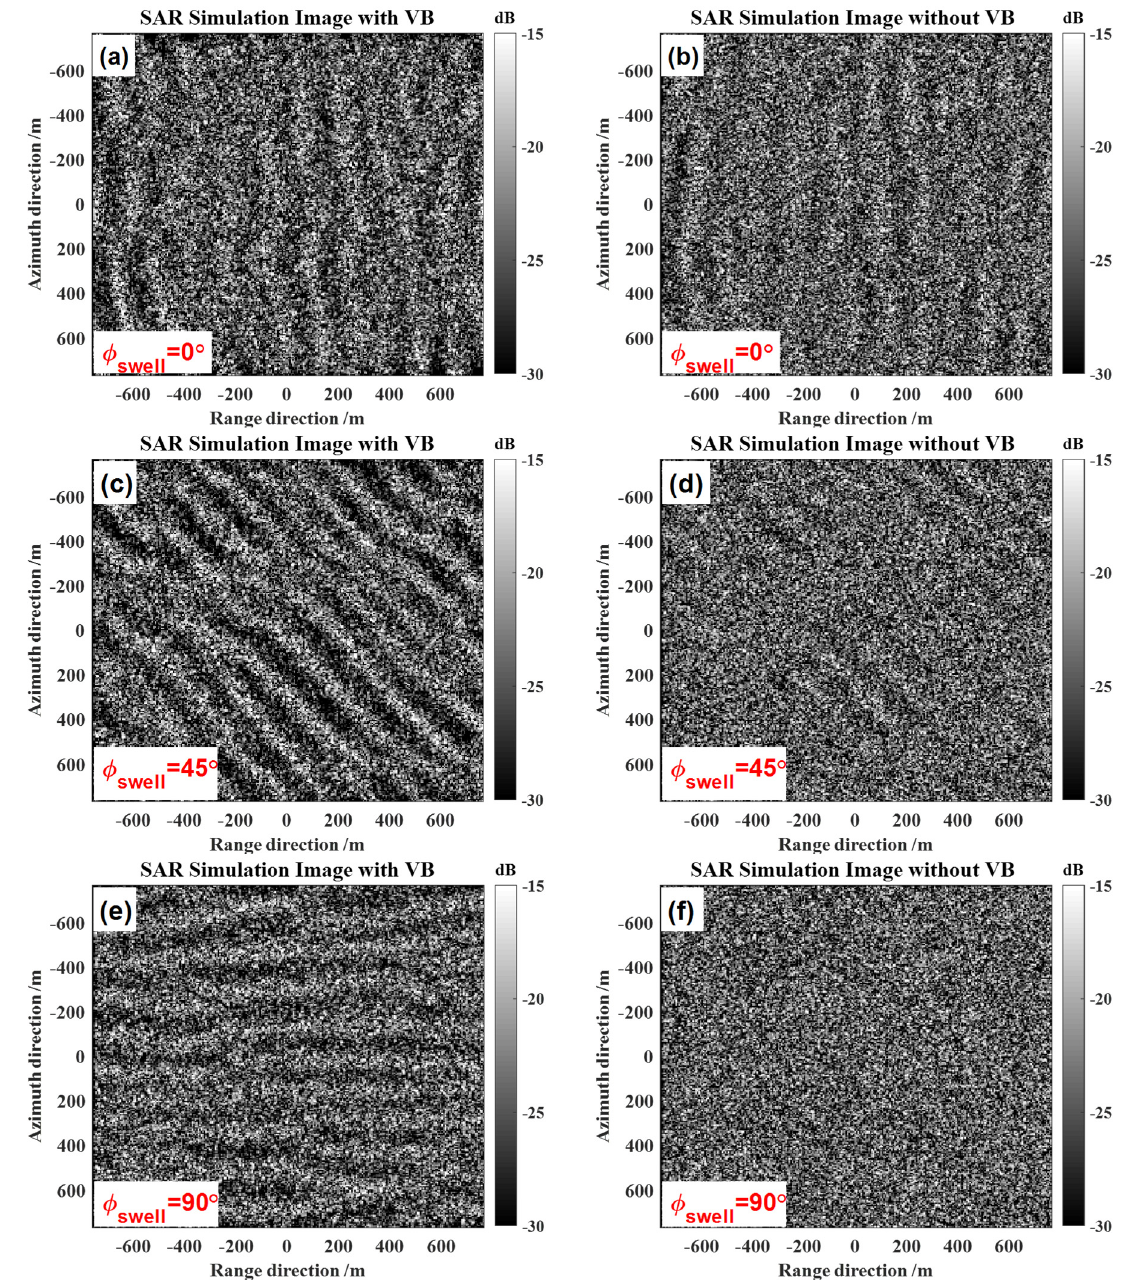
φ = ° , swell φ = ° , ( d ) swell